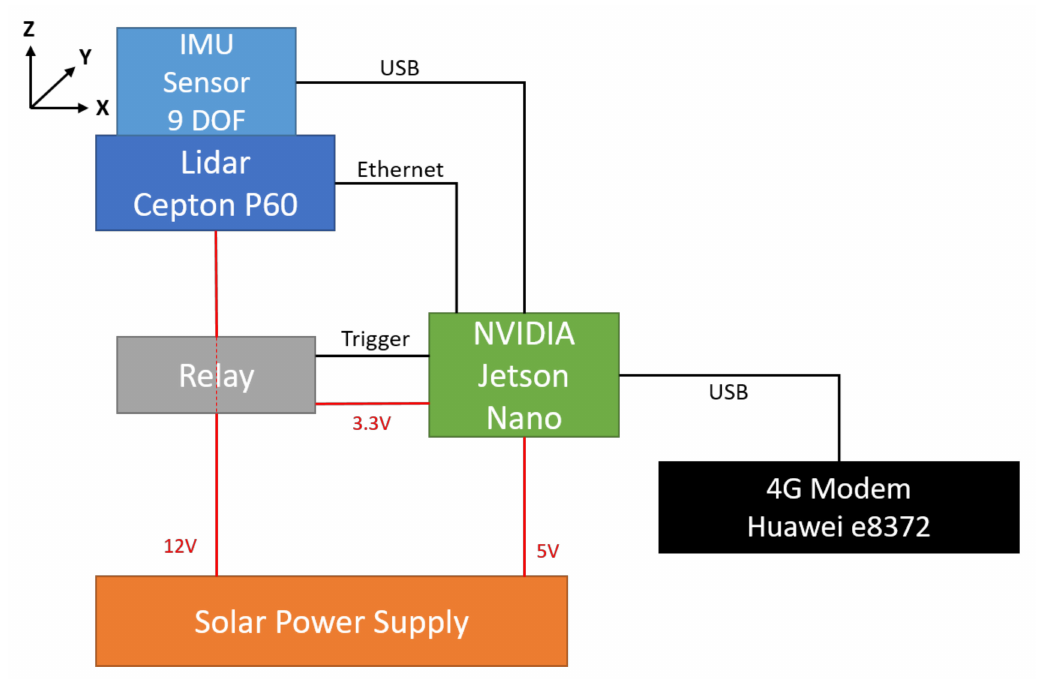
Figure 5. Block Diagram of Remote Monitoring